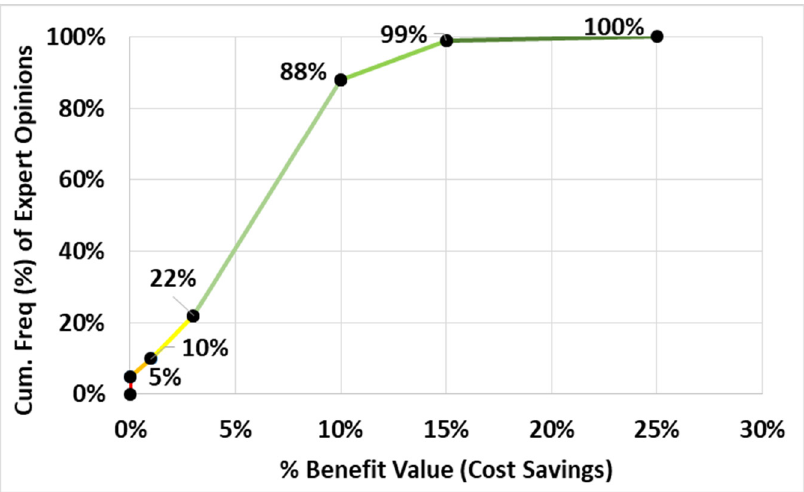
Figure 8. Cost of water benefits: Cumulative frequency (y-axis, annotation) of benefit values (x-axis), scaled per every 100 responses by experts. The line is colour coded in the same way as Figure 7 to enable easy comparison.